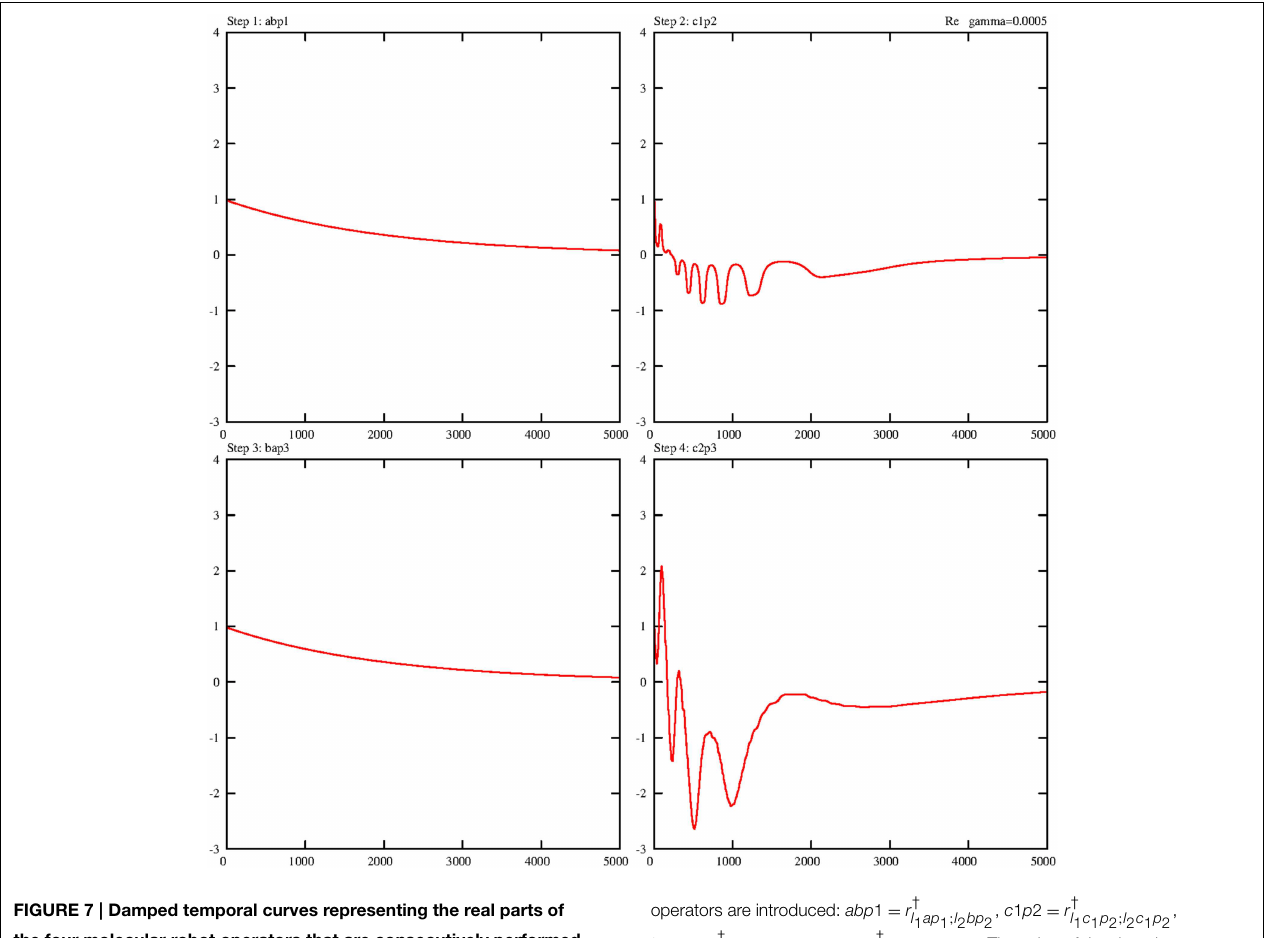
FIGURE 7 | Damped temporal curves representing the real parts of the four molecular robot operators that are consecutively performed by the steps 1–4. The following algebraic equivalents for the selected